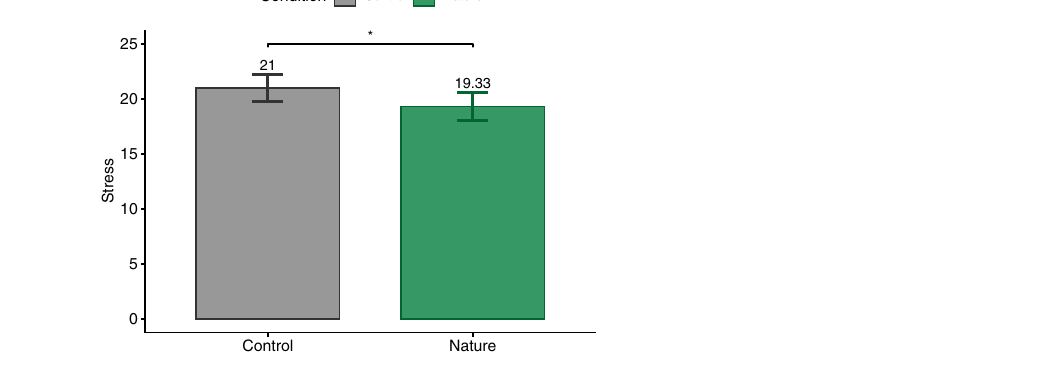
Figure 7. Perceived stress scale (PSS).